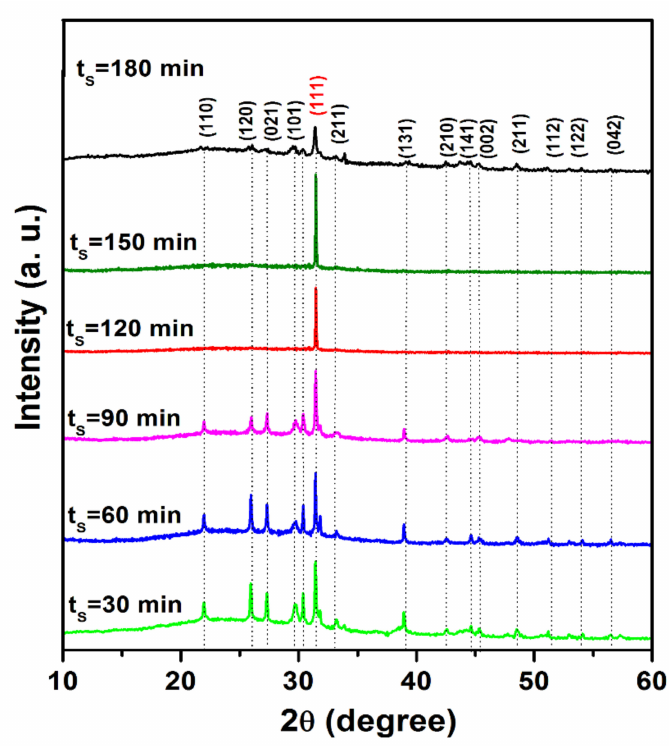
Figure 3. X-ray diffraction (XRD) patterns of metallic tin precursor films sulfurized at various time